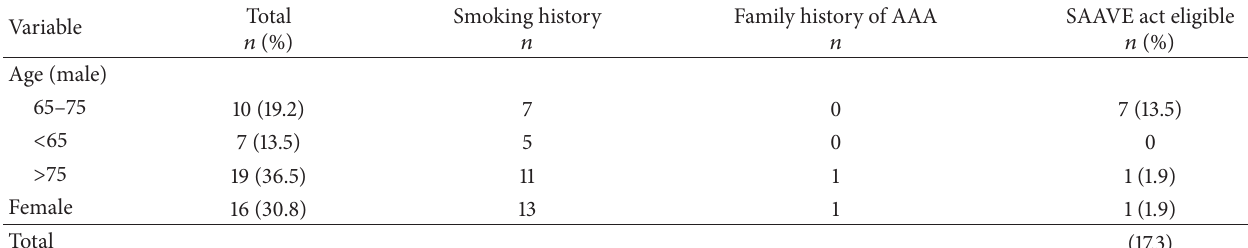
Table 1: SAAVE act eligibility in 52 study patients with ruptured AAA at the time of